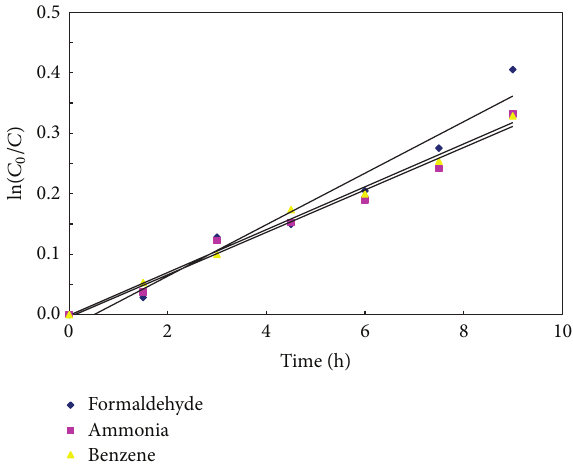
Figure 5: Kinetics of degradation reaction of the mixed